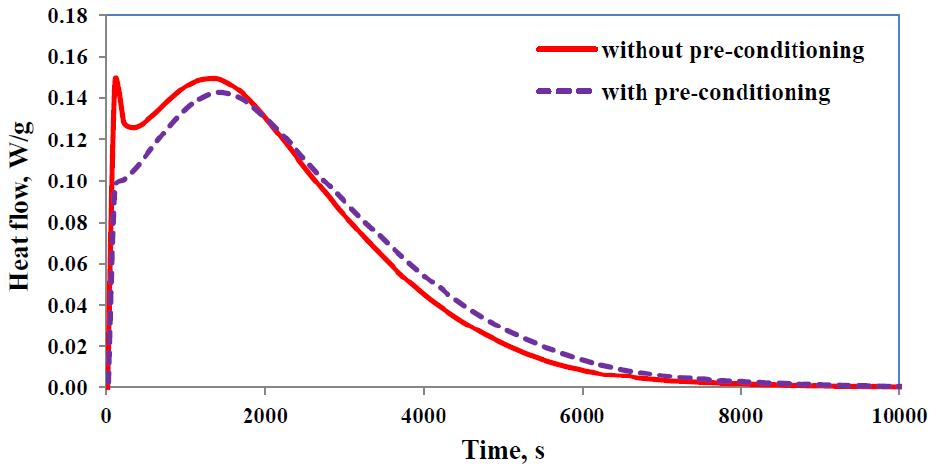
Figure 3. Comparison of isothermal cure curves at 150 °C for TGAP/MMT/DDS nanocomposites containing 5 wt% clay, with (purple curve, dashed line) and without (red curve, full line) pre-conditioning. Exothermic direction is